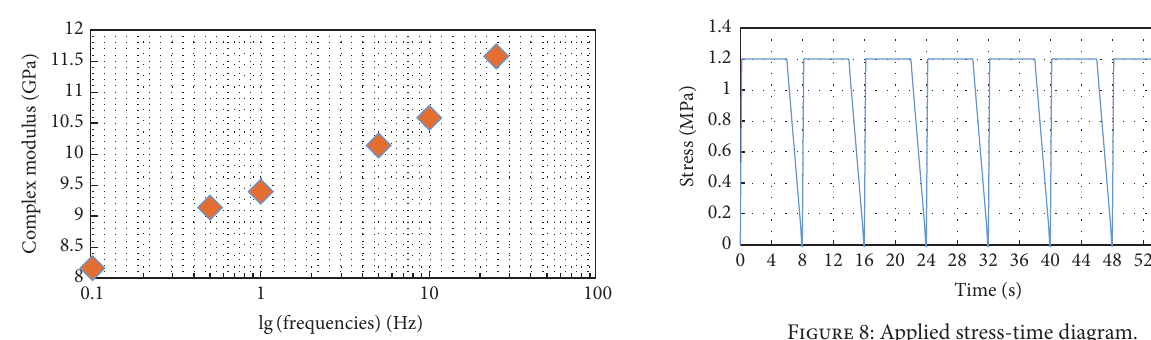
model and the verified incremental constitutive model can be used to predict the mechanical response of asphalt mixture under repeated creep